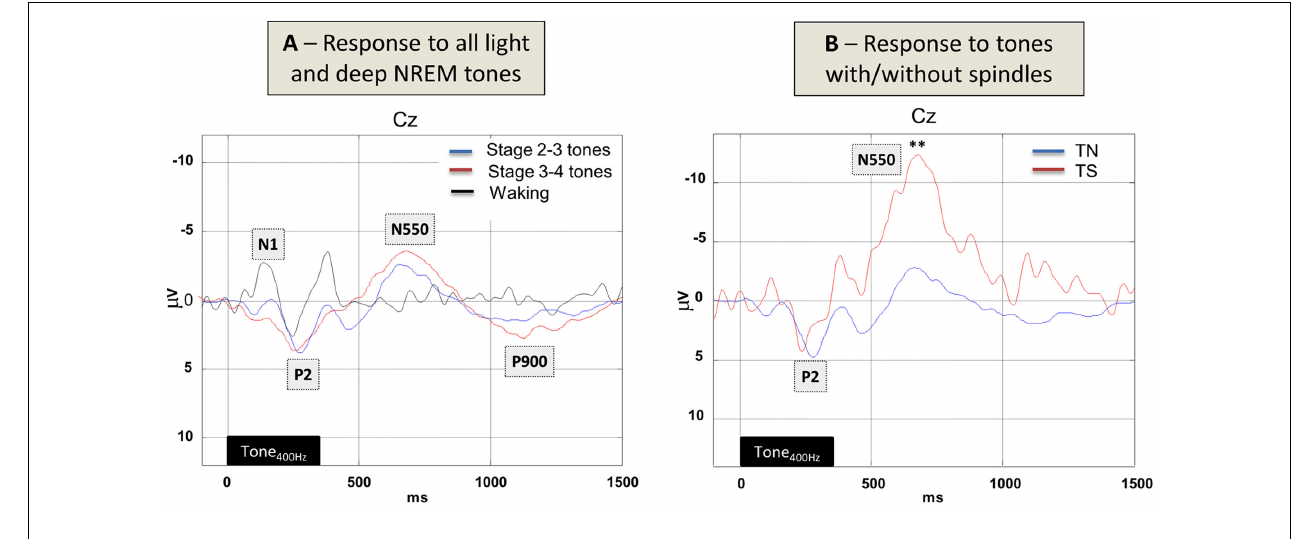
tones presented during (TS, red line) or outside spontaneously occurring stage 2–3 sleep spindles (TN, blue line) are depicted. Note the massive late negativity evoked by tones falling into sleep spindles. Data are bandpass filtered between 0.5 and 20Hz and reflect the grand-average of 12 subjects.